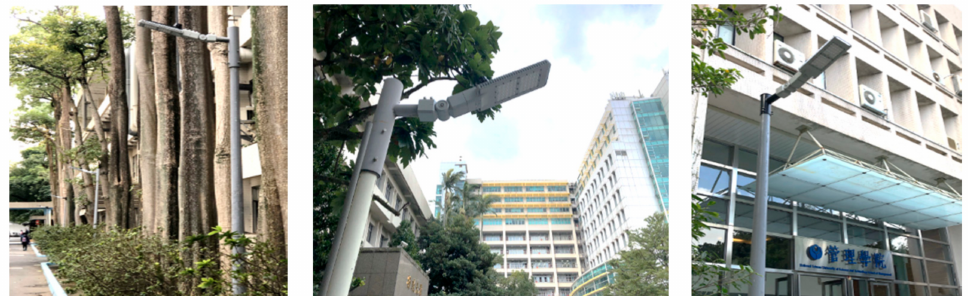
Figure 20. Streetlight replacement.